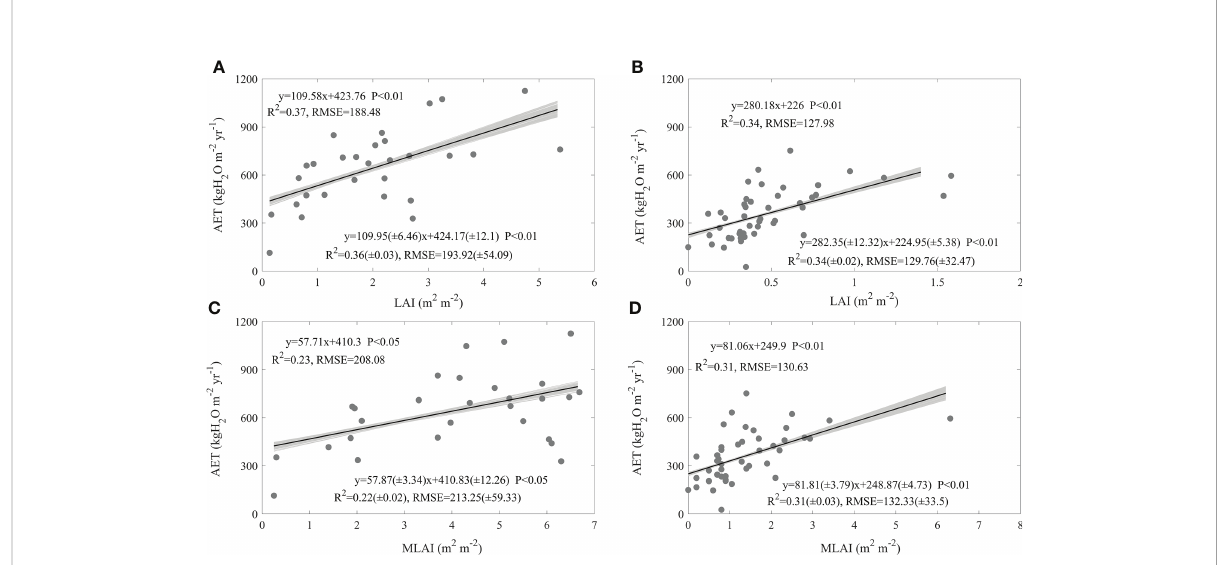
FIGURE 7 Effects of mean annual leaf area index (LAI, A, B ) and maximum leaf area index (MLAI, C, D ) on the spatial variations of annual evapotranspiration (AET) in forests (A, C) and grasslands (B, D) in China. The grey lines are regression lines generated from the random error adding AET, whose statistics are presented in the right bottom of each